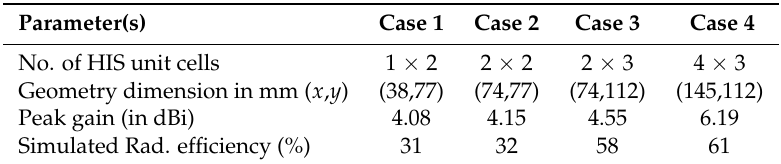
Figure 22. Top view of the wearable loop antenna on top of various HIS sizes: ( a ) case 1, ( b ) case 2, ( c ) case 3, and ( d ) case 4. Table 1. Numerical parametric study for the performance of the wearable loop antenna (cotton fabric) on top of several HIS structure